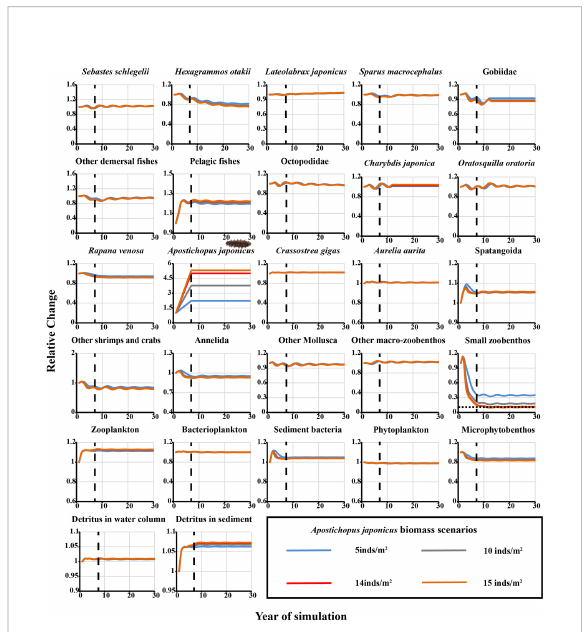
FIGURE 4 Predicted relative changes in biomass of each functional group for the selected four representative scenarios of the sea cucumber Apostichopus japonicus stock enhancement in the Ecopath Model of Laizhou Bay marine ranching area. Dashed black line, time after which the biomass level of A. japonicus remained constant; horizontal black dotted line, 10% threshold of initial biomass.